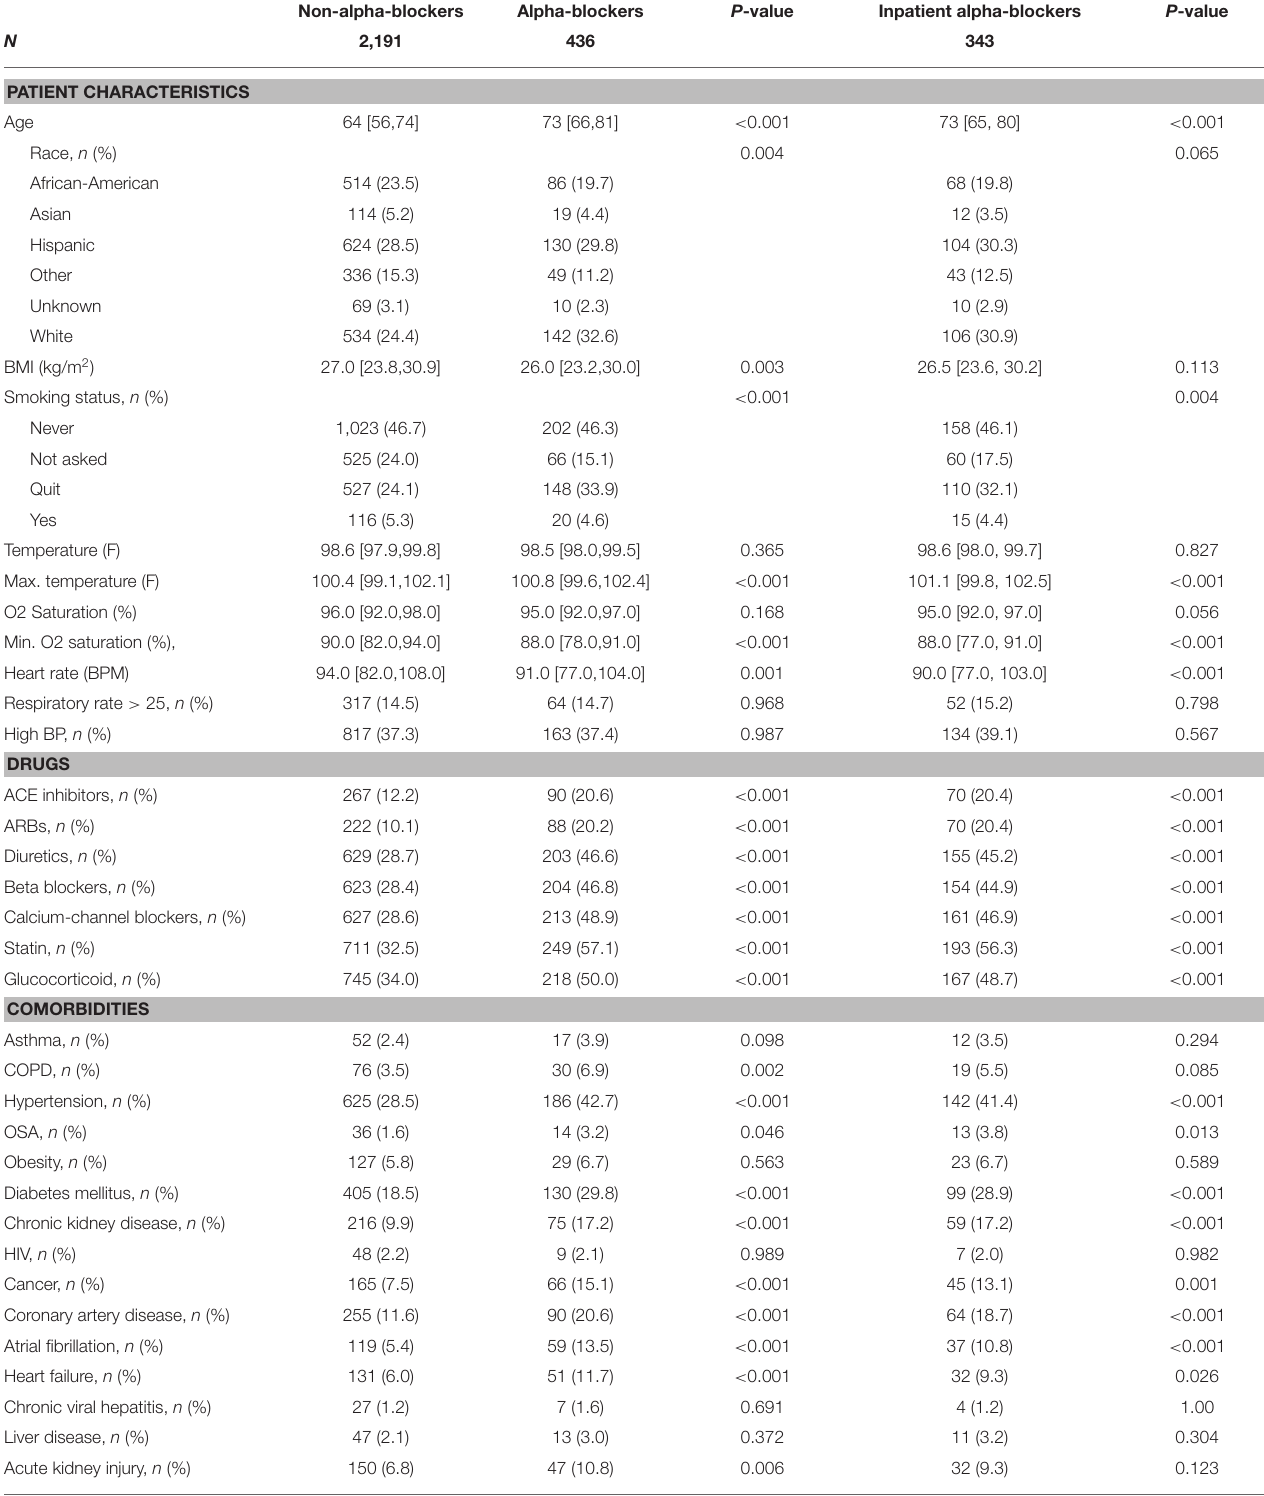
TABLE 1 | Baseline characteristics and hospitalization outcomes, by alpha-1-blocker exposure. Non-alpha-blockers Alpha-blockers Inpatient